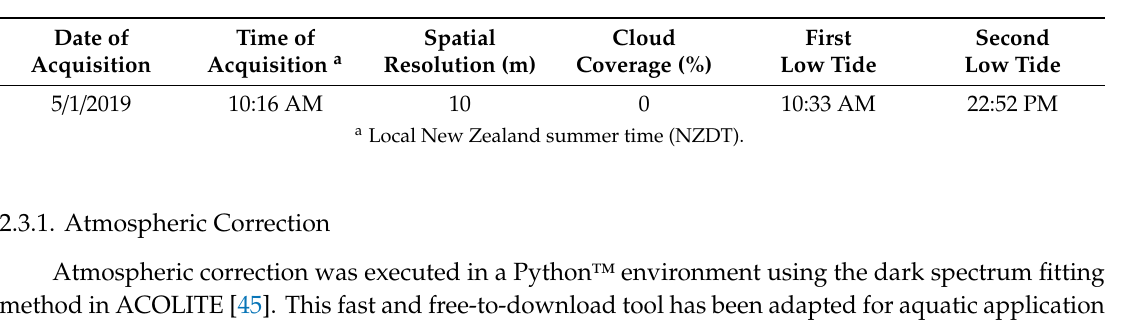
Table 1. Sentinel-2 data acquisitions used for seagrass mapping in this study.